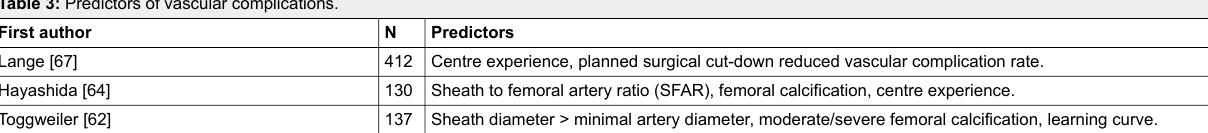
Table 3: Predictors of vascular